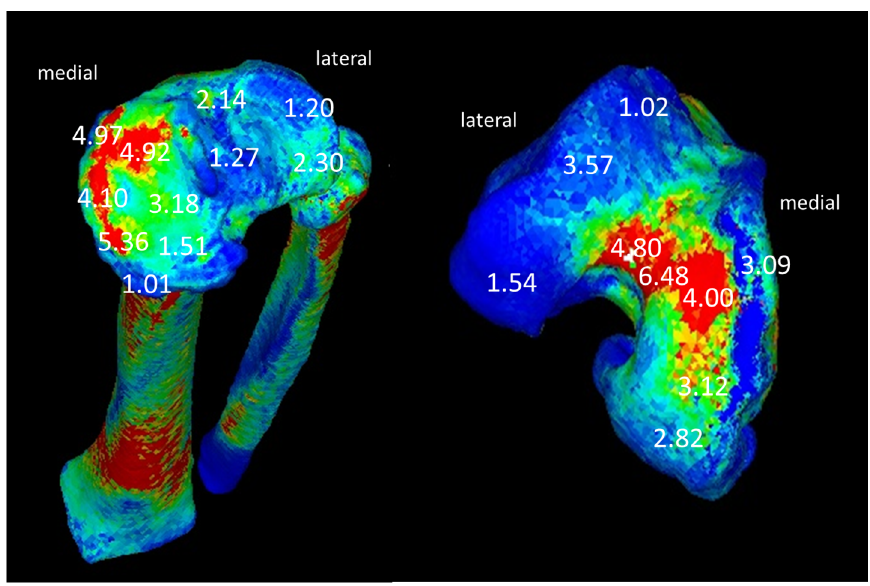
Figure 4. Compression stress using CT-FEM on the articulating surface of the femur and tibia.